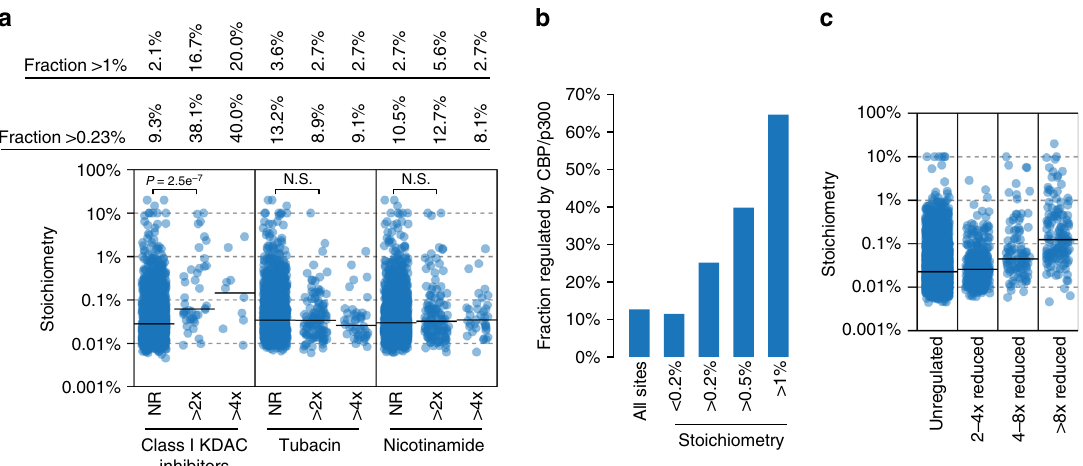
Fig. 5 Stoichiometry of deacetylase- and CBP/p300-regulated acetylation sites. a The category scatterplot shows the distributions of acetylation sites that are not regulated (NR), more than two-fold (>2×) upregulated, or more than four-fold (>4×) upregulated, by the indicated deacetylase inhibitors as determined by 21 . Class I KDAC inhibitors primarily target HDACs 1, 2, 3, and 8, and were determined by the median SILAC ratio of apicidin, MS-275, valproic acid, and sodium butyrate-treated HeLa cells. Tubacin is an HDAC6 inhibitor and nicotinamide inhibits Sirtuin deacetylases, but the regulated sites are mostly attributed to SIRT1 21 . b CBP/p300 regulates an increasing fraction of high stoichiometry acetylation sites. CBP/p300-regulated sites were determined by 12 . c Acetylation sites that are most affected (>8× reduced) by loss of CBP/p300 activity have higher median stoichiometry than sites that are only modestly affected (2 – 4× reduced). Source data are provided as a Source Data fi